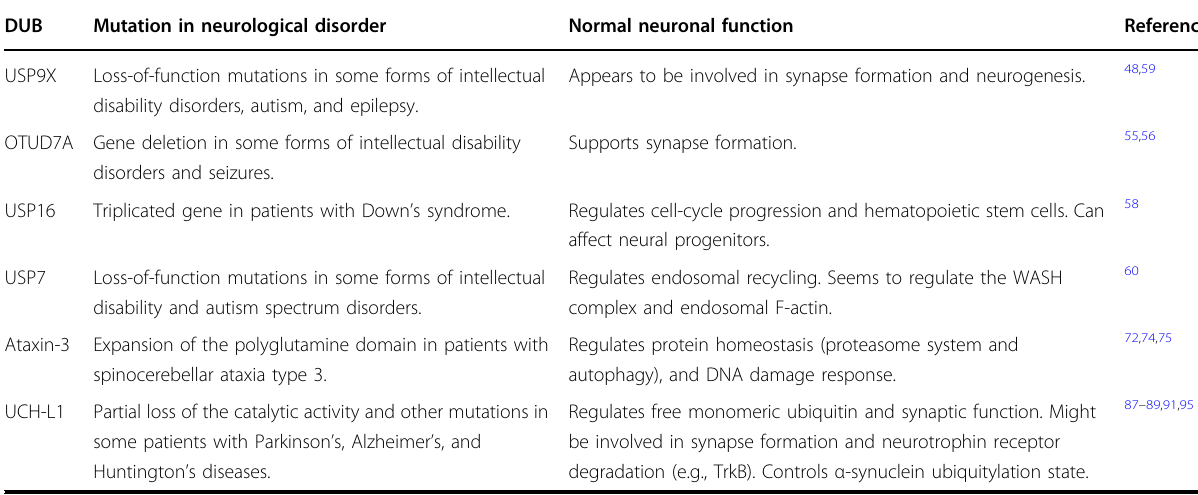
Table 1 Identi fi ed DUB mutations in humans with neurological disorders and proposed mechanisms in neuronal